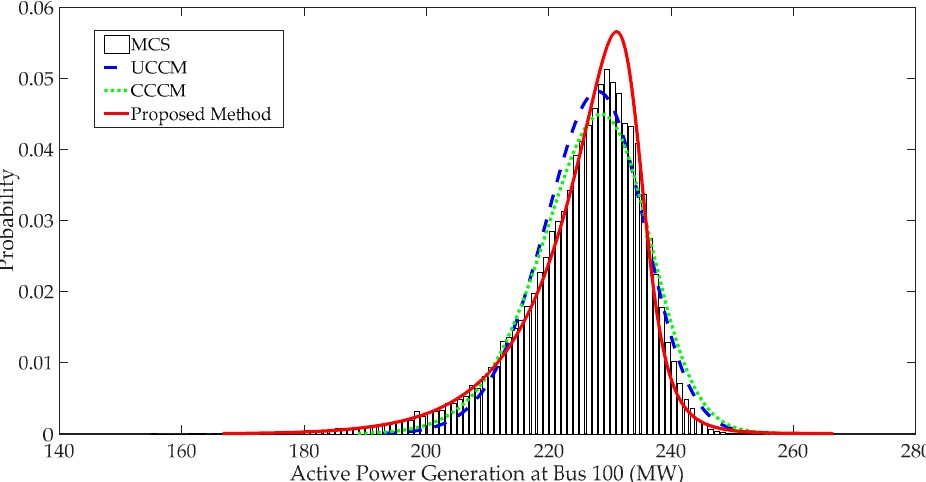
Figure 9. PDFs of active power generation at bus 100 (modified IEEE 118-bus test system).